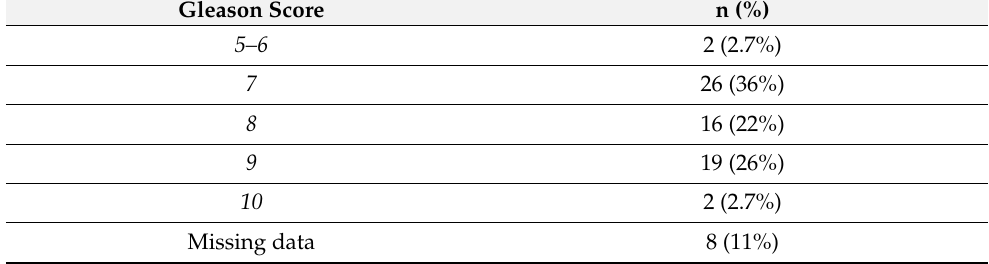
Table 2. The Gleason scores of the cohort at the time of primary diagnosis.